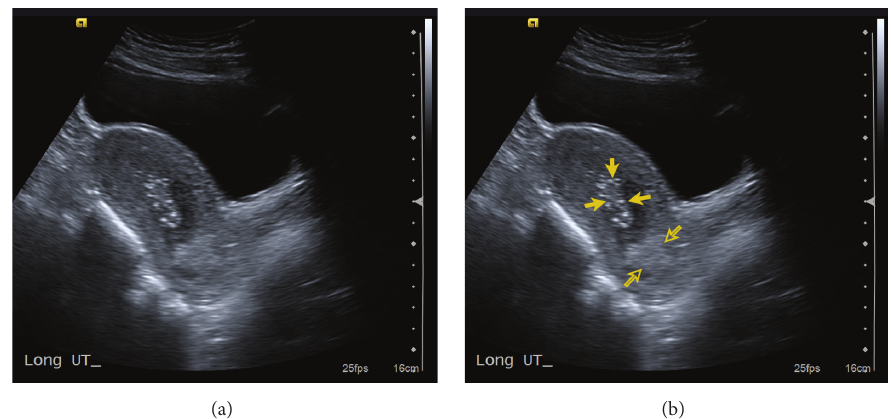
Figure 1: (a) TA Sag Uterus . Transabdominal sagittal view of the uterus shows thickened, heterogeneous, and hyperechoic material within the endometrial cavity. There is also echogenic material located in the lower uterine segment. (b) Opaque arrows indicate heterogeneous echogenic endometrial tissue. Open arrows indicate echogenic material in the lower uterine segment near the cervical os.